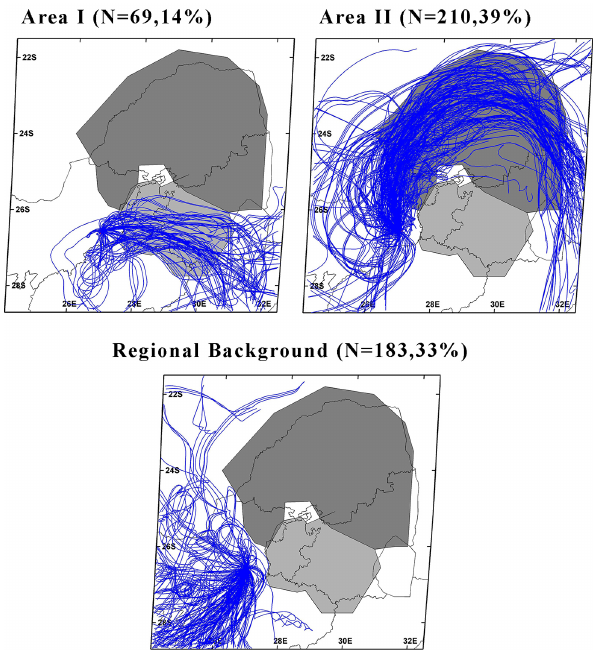
Figure 4. Graphical representations of back trajectories considered as passing over the defined source regions. The percentage of the trajectories considered as passing over a specific source region and the number of trajectories it represents are provided in brackets.